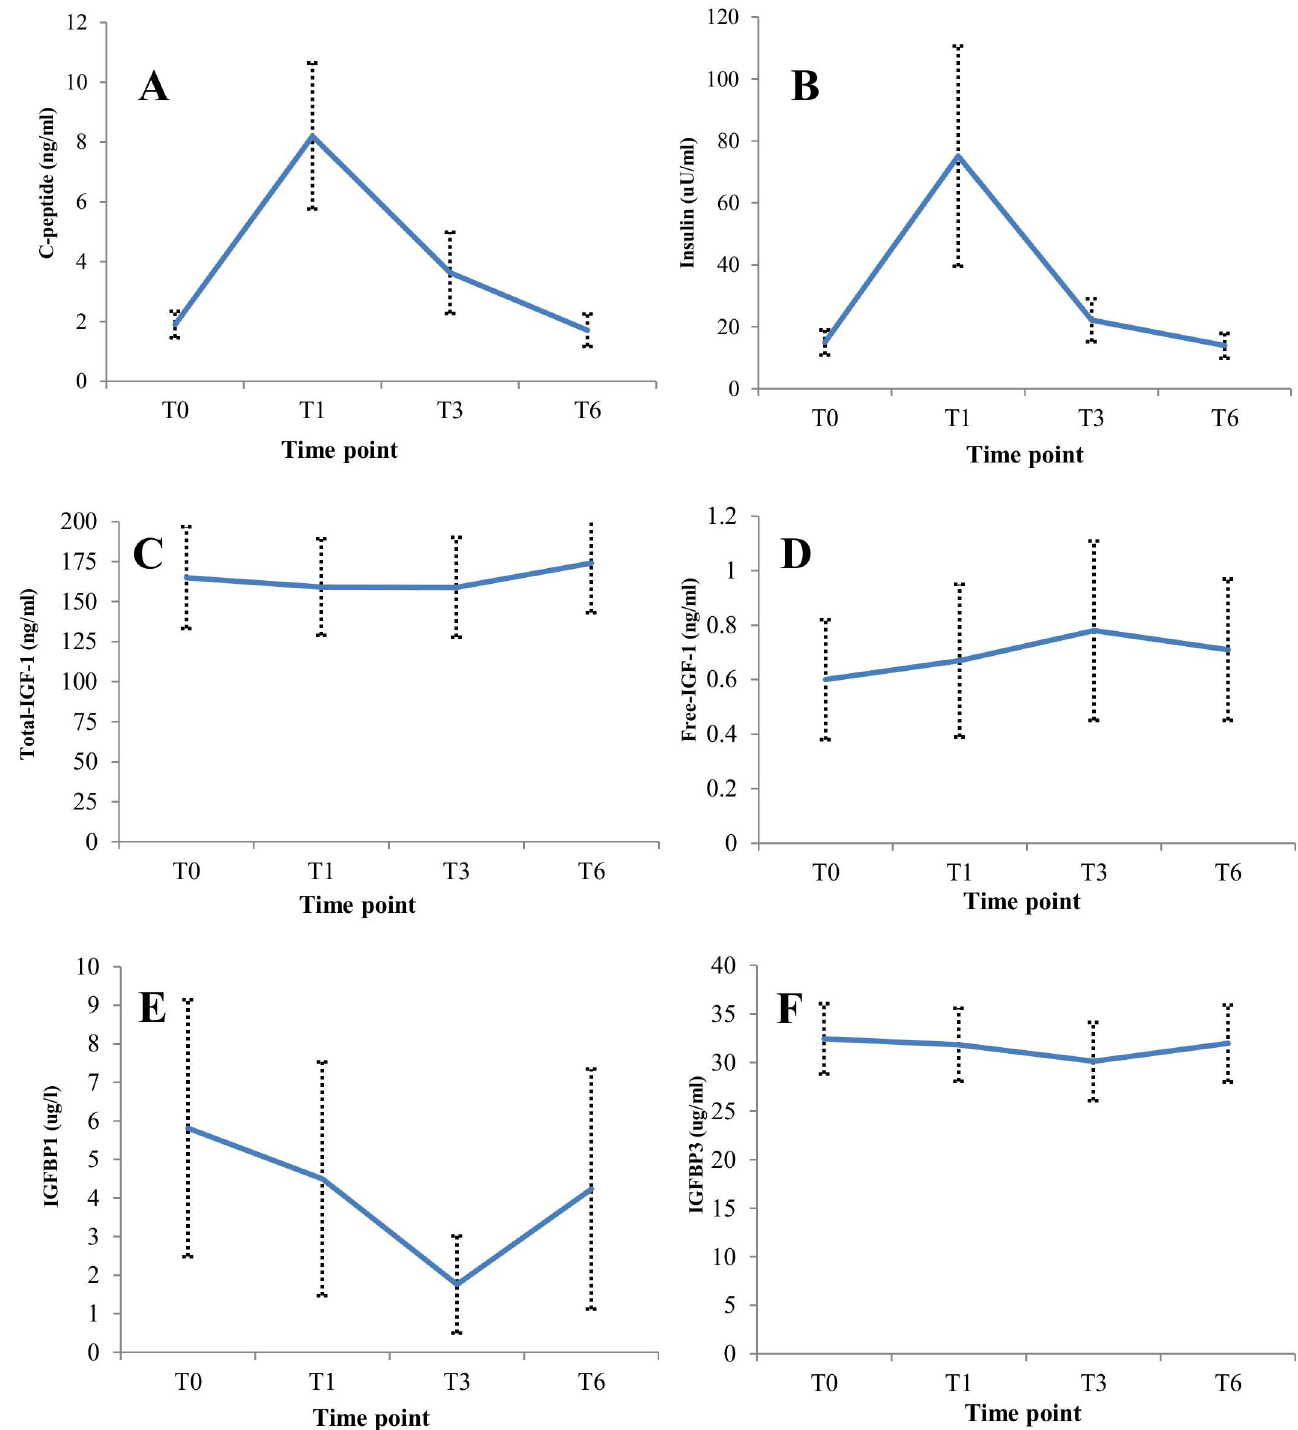
Fig 1. Medians and median absolute deviation of serum (A) C-peptide, (B) insulin, (C) total IGF-1, (D) free-IGF-1, (E) IGFBP-1, and (F) IGFBP-3 after an overnight fast (T0), and 1 hour (T1), 3 hours (T3), and 6 hours (T6) after the researchbreakfast.